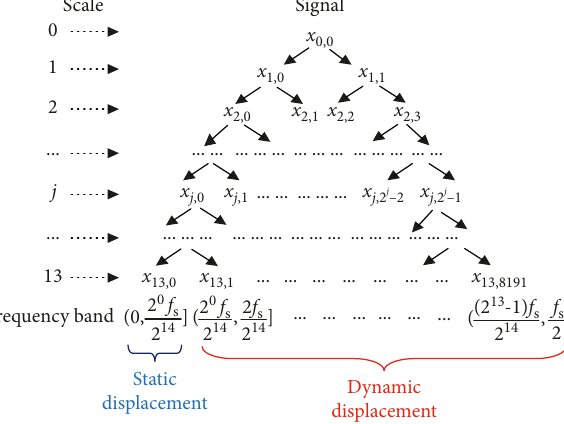
Figure 4: Tree structure of the wavelet packet coefficients.